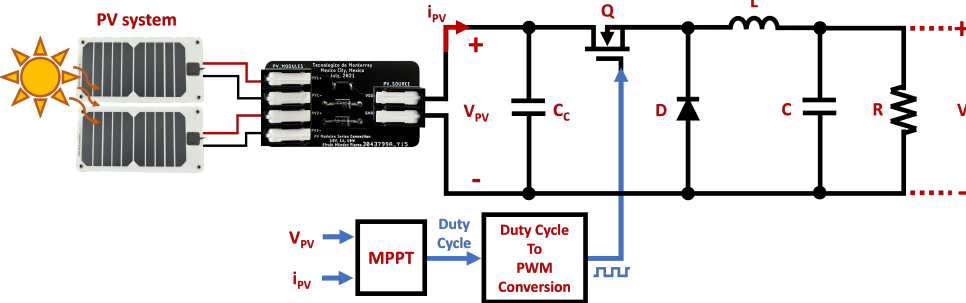
Figure 18. PV array integration for the case study